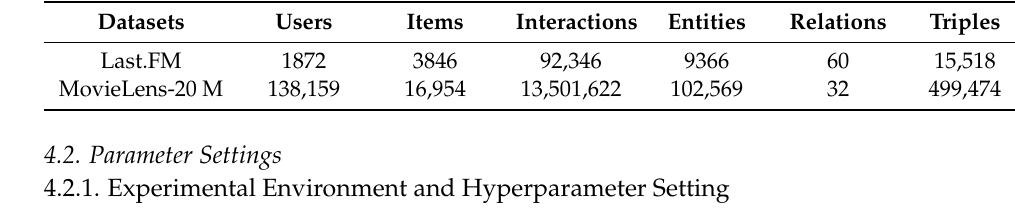
Table 1. Statistics of datasets.